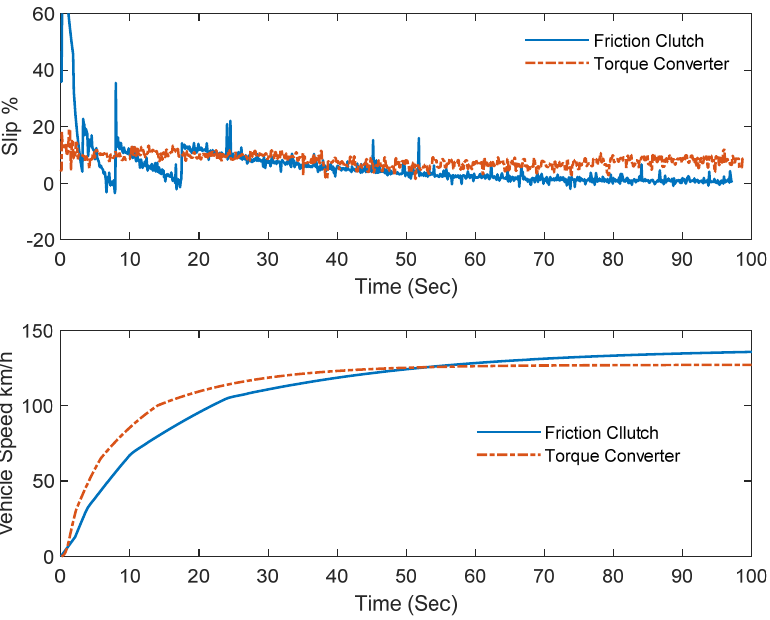
Figure 11. Slipping ratios and speeds.